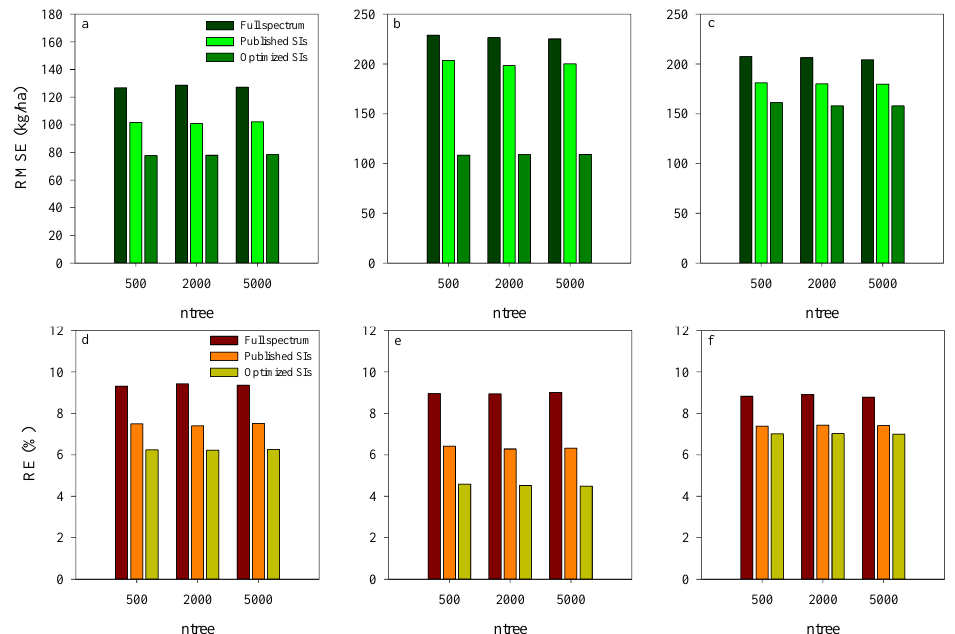
Figure 4. The RMSE and RE of training dataset using RF model based on different input variations at tuber formation stage ( a , d ), tuber bulking stage ( b , e ), and the combined stage of tuber formation and tuber bulking ( c , f ).